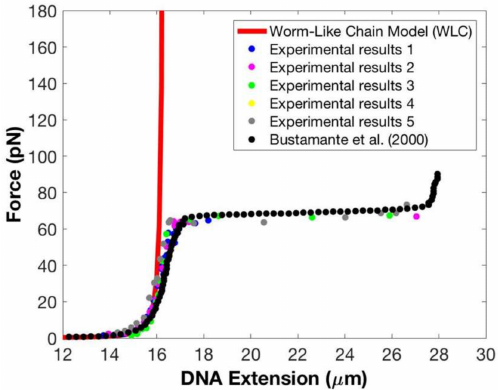
Figure 4. Replications of force–extension measurements using five different magnets and comparison to calibration data. The WLC is plotted as red solid line. The black solid circles represent the experimental results on λ -DNA using optical tweezers as presented in Strick et al. [11]. The remaining solid colored circles represent data from our experimental replications.